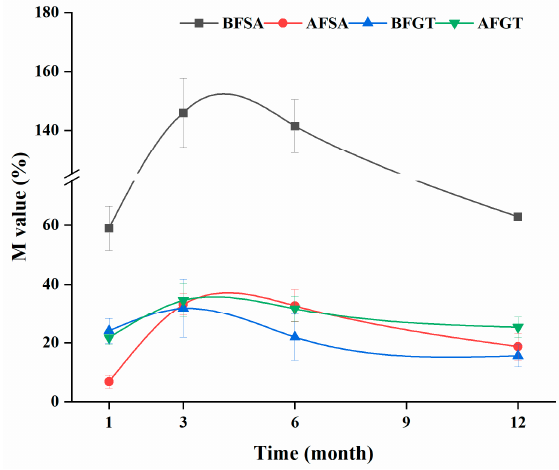
Figure 2. Effects of added sinapic acid and grape tannin on copigmentation effect value (M) of cherry wine.